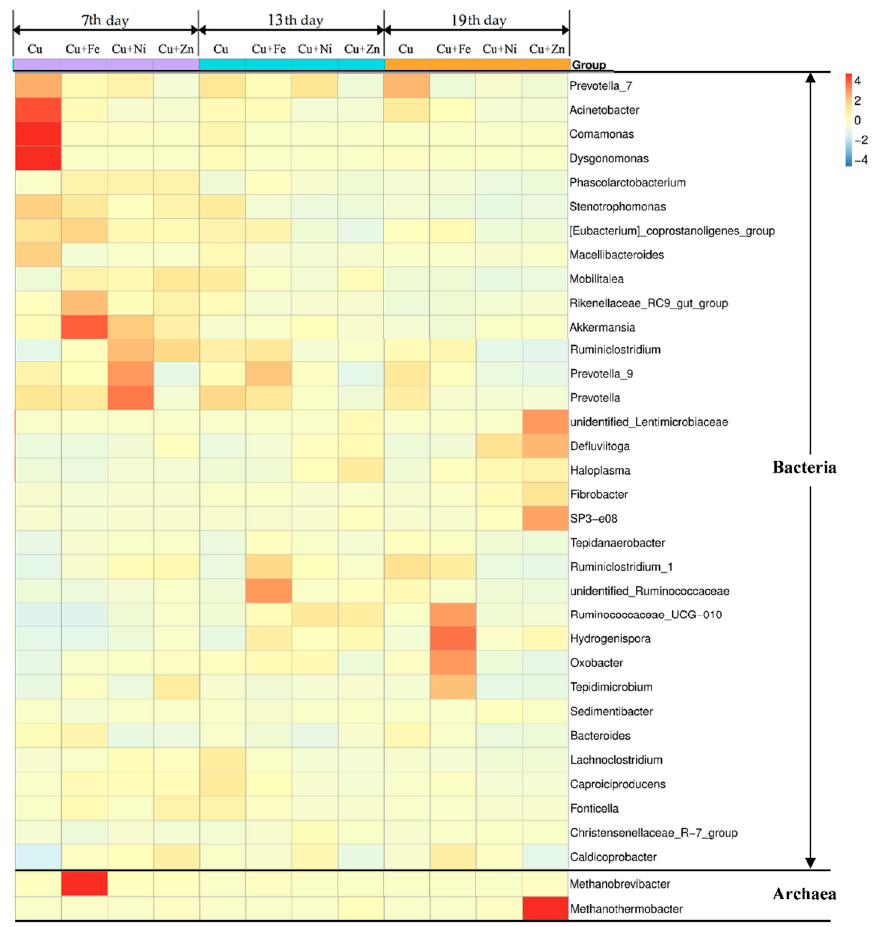
Figure 7. Microbial communities annotated on the level of genus in Cu, Cu + Fe, Cu + Ni and Cu + Zn treatments on the 7th, 13th and 19th day of fermentation. Colors represent the normalized sequences number of the operational taxonomic units (OTUs) in the samples (blue: low sequences number of OTUs; red: high sequences number of OTUs).